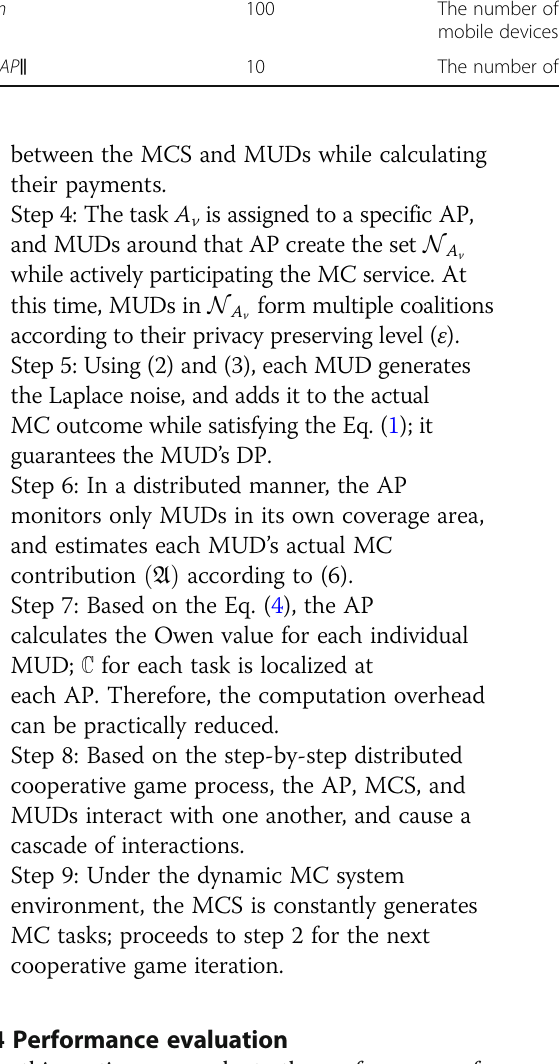
Table 2 System parameters used in the simulation experiments Sensing tasks